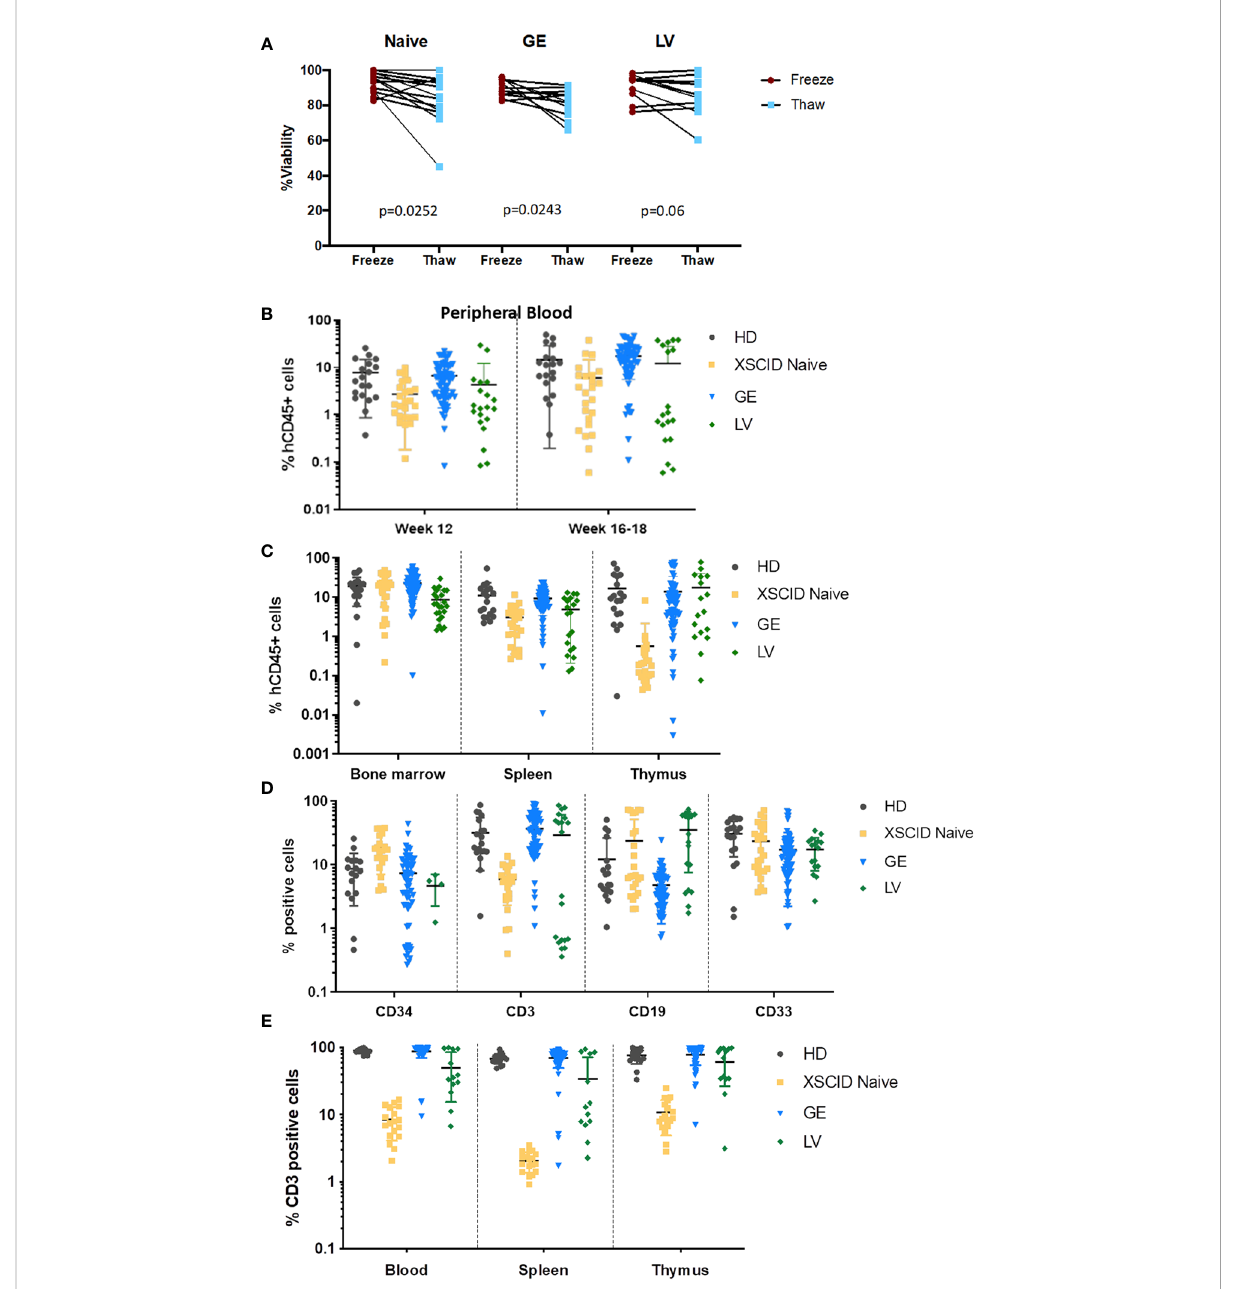
FIGURE 4 In vivo engraftment and T-cell development in immunode fi cient mice transplanted with GE- and LV-treated XSCID HSPCs (A) Percentage of cell viability at freezing post processing and at thaw (second cycle freeze-thaw) following processing of XSCID HSPCs Naive and after GE or LV- transduction (n = 6-10 independent experiments). (B) Analysis of peripheral blood from mice transplanted with HSPCs from HD, XSCID Naive or GE- and LV-treated at weeks 12 and 16-18 for human engraftment (hCD45 + ). (C) Level of human CD45 + engraftment in mice bone marrow, spleen and thymus at 16-20 weeks after transplant with HD, XSCID Naïve, GE- and LV-treated HSPCs. (D) Percentages of human CD34 + , myeloid (CD33 + ), B lymphoid (CD19 + ) and T lymphoid (CD3 + ) cells in the BM at week 16-18 post-transplant (gating on hCD45 + ). (E) Percentage of CD3 + T cells in the PB, spleen and thymus at week 16-20 post-transplant. HSPCs are from 2 HD and 4 XSCID patients. Data are showed as mean ± standard deviation. Each symbol indicates a single